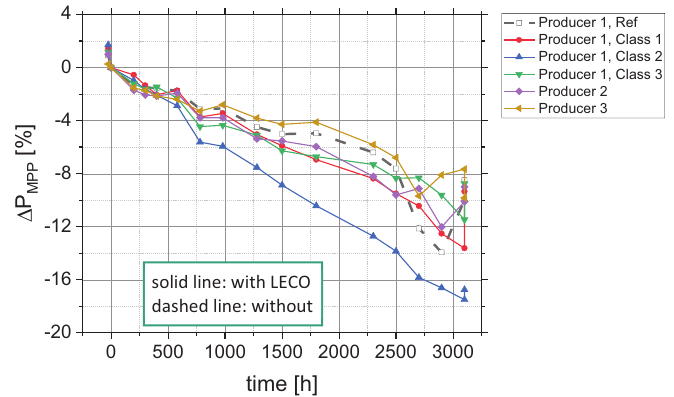
Fig. 5. Degradation of STC power of LECO modules in extended Damp heat test.